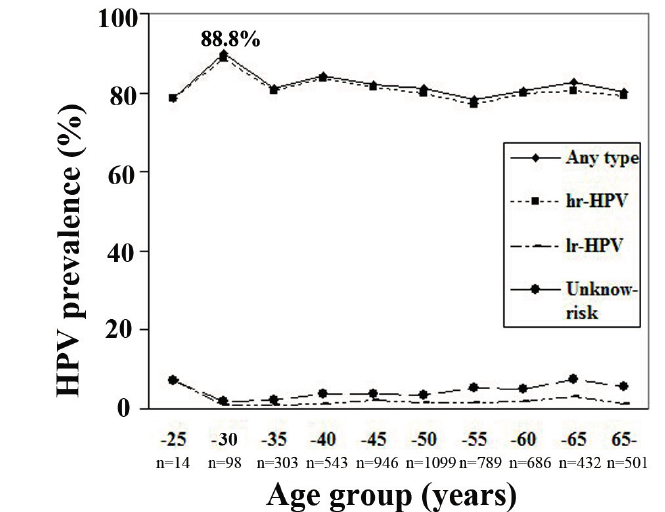
Figure 1. Age-specific of HPV infection in hospital-based female population in Zhejiang Province. High-risk HPV types included HPV-16, -18, -31, -33, -35, -39, -45, -51, -52, -56, -58, -59, -66 and -68; Low-risk HPV types included HPV-6,-11, -42, -43 and -44 and unknown-risk types included HPV-53 and -81(equivalent to CP8304). The peak of hr-HPV infection reached 88.8% in 26–30 years old